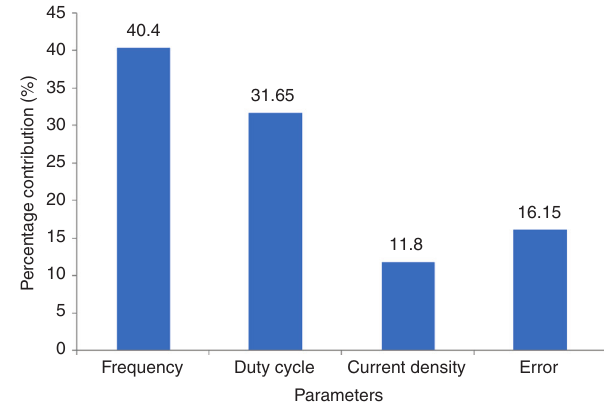
Figure 1 Percentage contribution of pulse plating parameters of Ni-nano-Al O composite coatings. 2 3